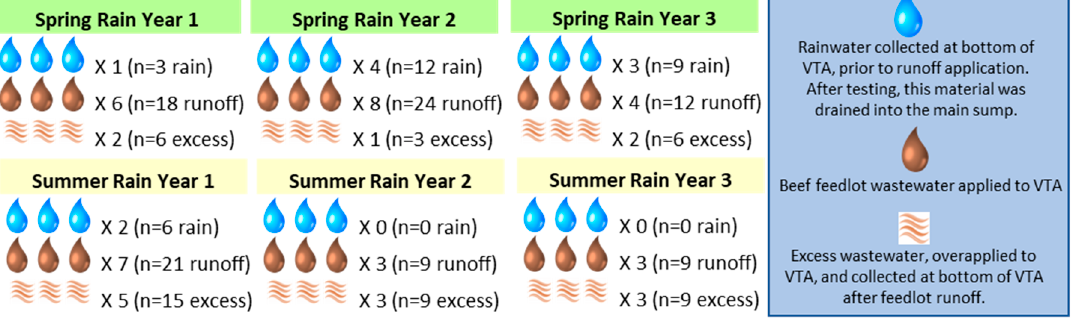
Figure 2. Experimental design.